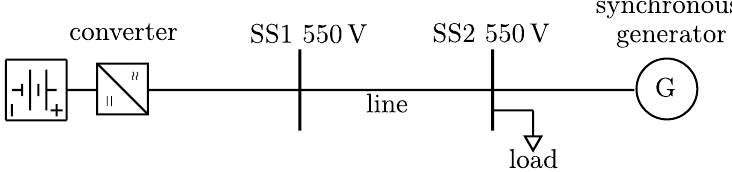
Figure 8. Microgrid used for the simulations.